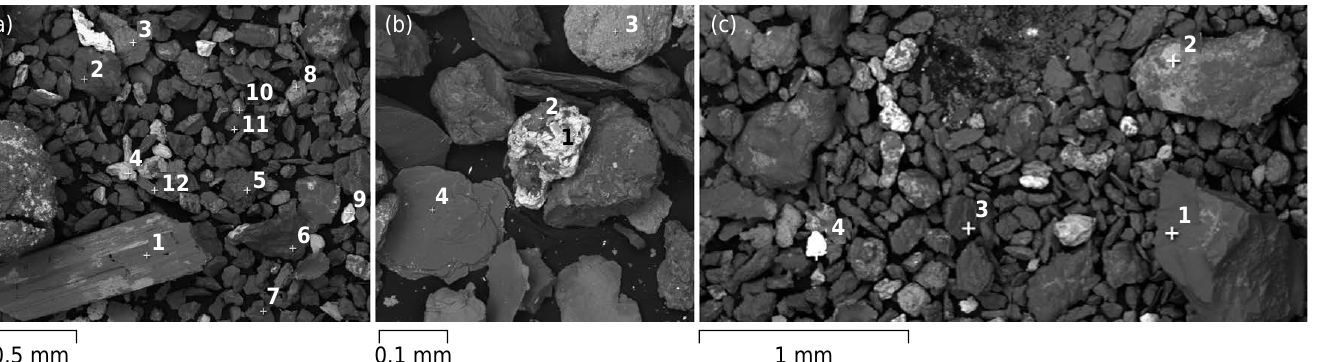
Figure 6. Scanning Electron Microscopy images of sand particles from sample 15 (area